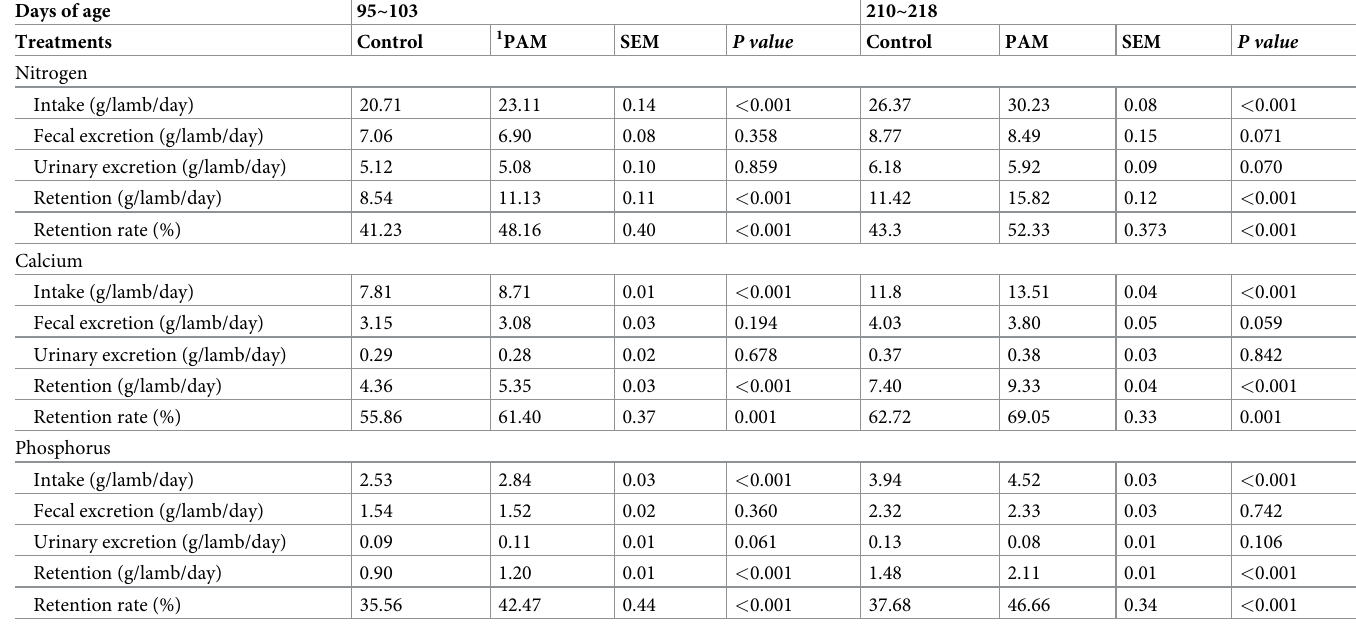
Table 4. The effect of supplementation with polyacrylamide on the metabolism of nitrogen, calcium, and phosphorous in lambs. Days of age 95~103 Treatments Control Nitrogen